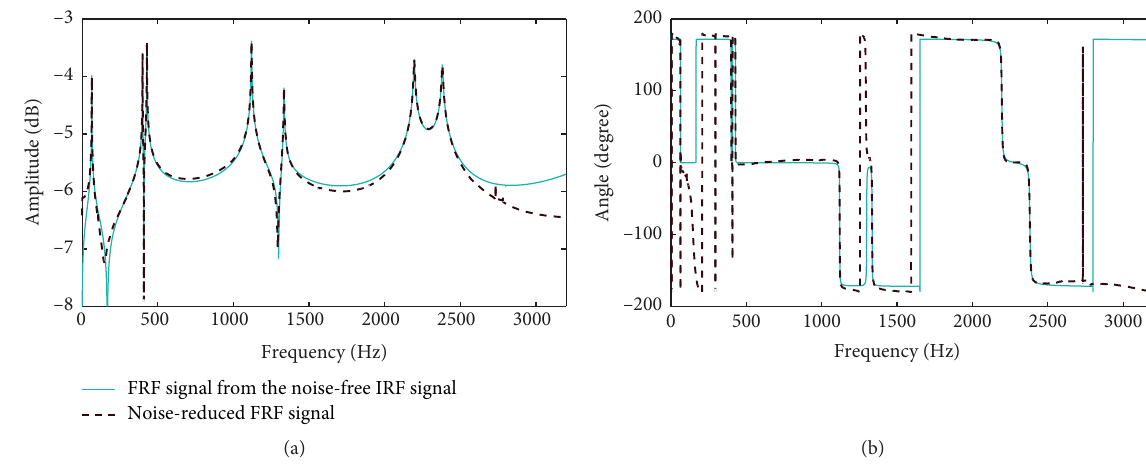
Figure 7: Noise reduction result of component signal reselection. (a) Energy spectrum. (b) Phase spectrum.